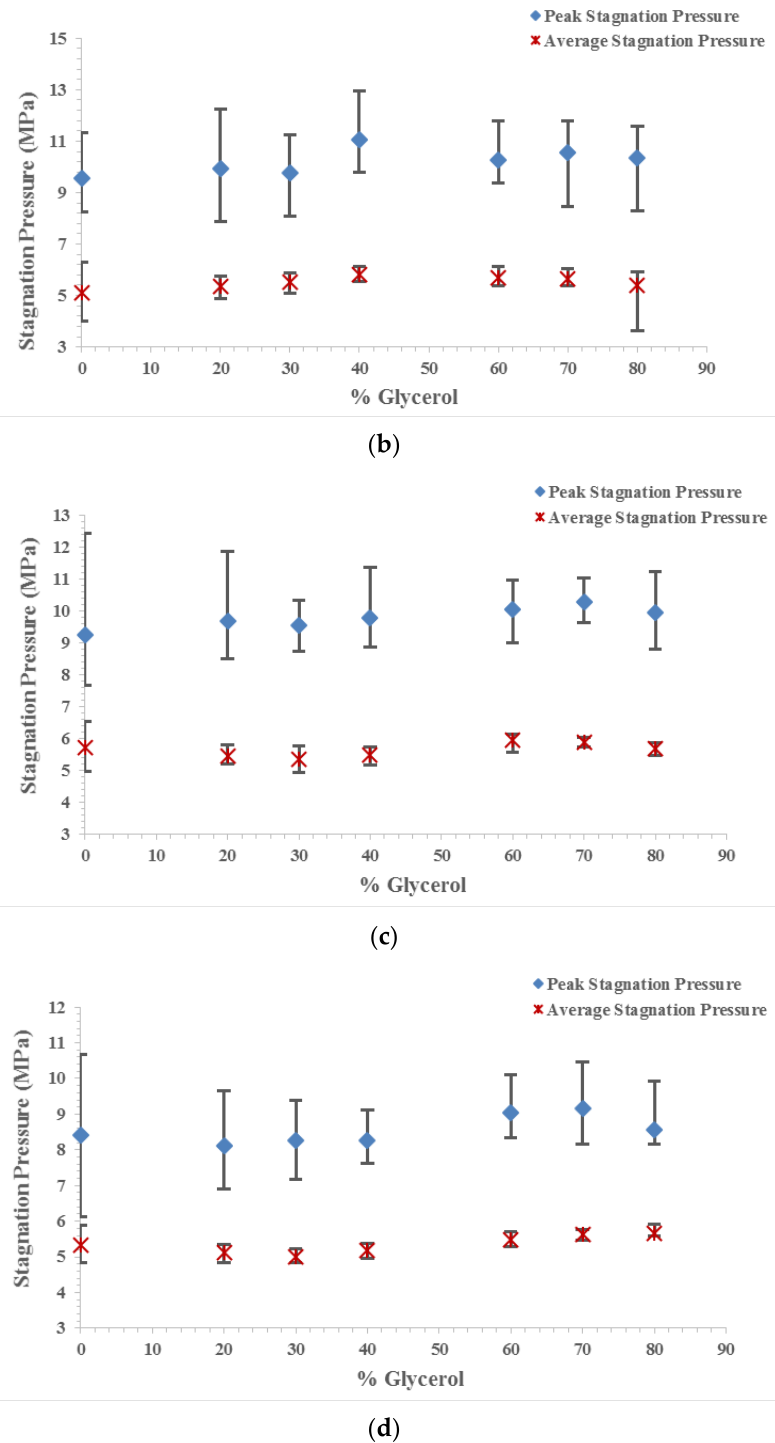
Figure 14. Experimental and targeted pressure profiles tested under various viscosities and nozzle sizes: ( a ) Nozzle 6, ( b ) 8, ( c ) 10 and ( d ) 12.